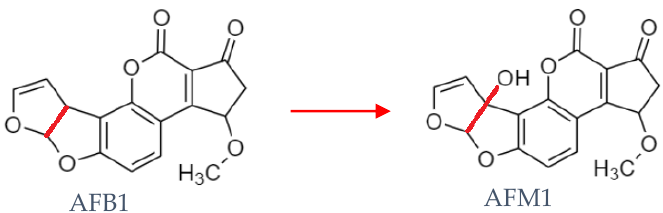
Figure 1. Illustration of the conversion from aflatoxin B1 (AFB1) to aflatoxin M1 (AFM1).